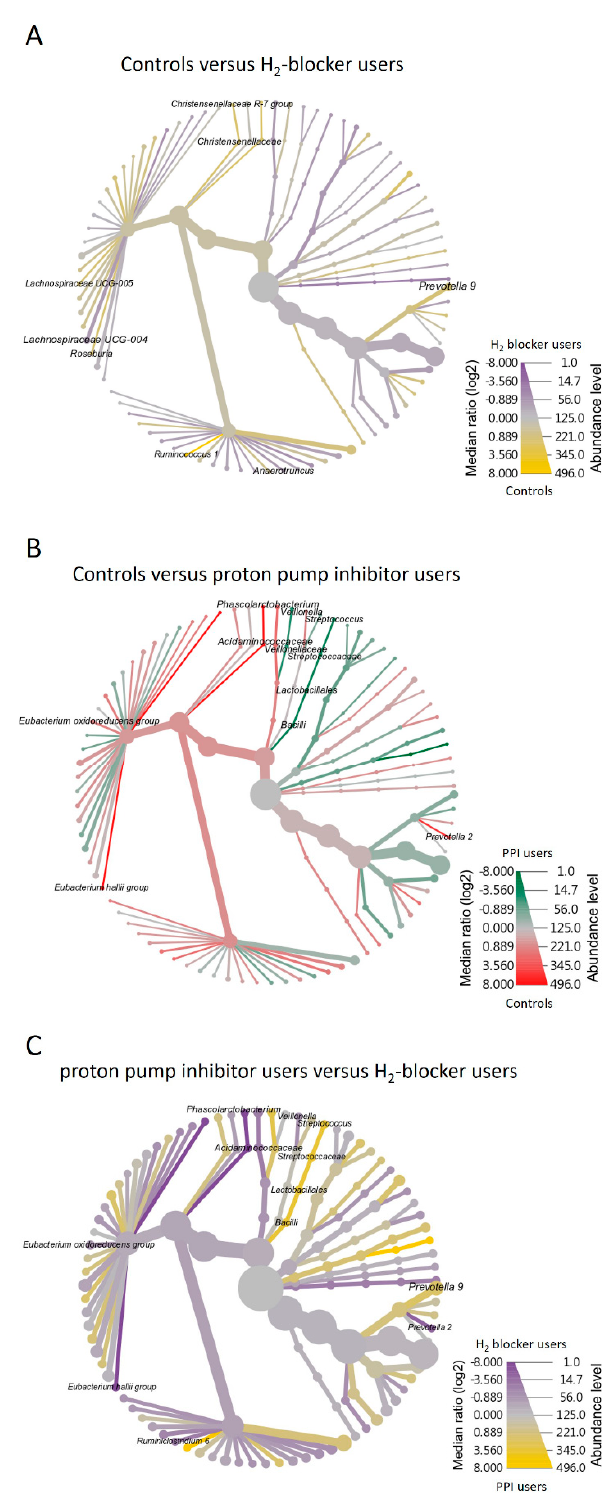
Figure 4. Heat tree visualization of taxonomic differences. A heat tree illustrates the taxonomic differences between H 2 -blocker users, proton pump inhibitor users, and controls. The color gradient and the size of the node, edge, and label are based on the log2 ratio of median abundance: ( A ) controls versus H 2 -blocker users; ( B ) controls versus proton pump inhibitor users; ( C ) H 2 -blocker users versus proton pump inhibitor users.